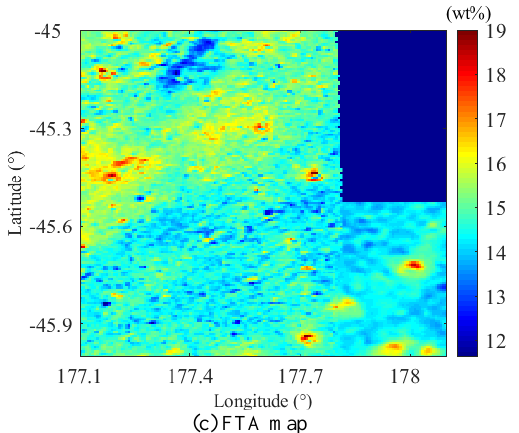
Figure 7 Geopography, elevation and FTA maps of landing site Figure 7(c) indicates that the FTA is unevenly distribution in the landing site, where the higher FTA occurs in the northwest part and the lower FTA occurs in the southeast part. However, the distribution is also in line towards the northeast direction, indicating the shallow layer of the landing site is totally covered by the ejecta from the impact event in the northeast part. Interestingly, the craters and their surroundings are materials with higher FTA, indicating that the material in depth is rich in